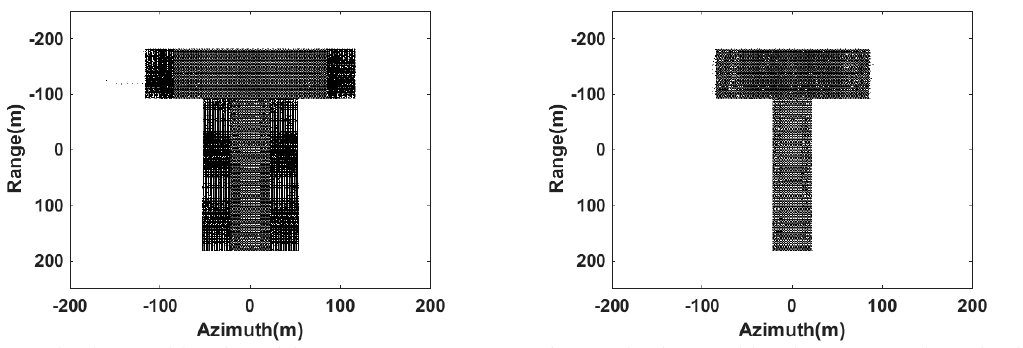
Figure 17. Imaged results of surface target simulation: ( a ) result obtained by the adding zeros operation; and ( b ) result obtained by the proposed method.